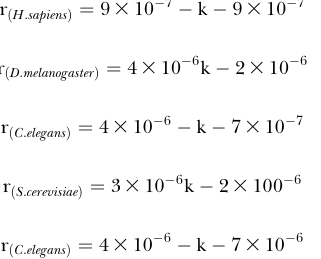
after duplication. Figure S2. Specificity of Binding Can Determine the Rate Change of Interactions in Groups of Proteins with the Same Connectivity (A) We binned all proteins according to the number of interactions with proteins originated before the split with the reference species and calculated the rates of change of interactions with recently duplicated proteins.